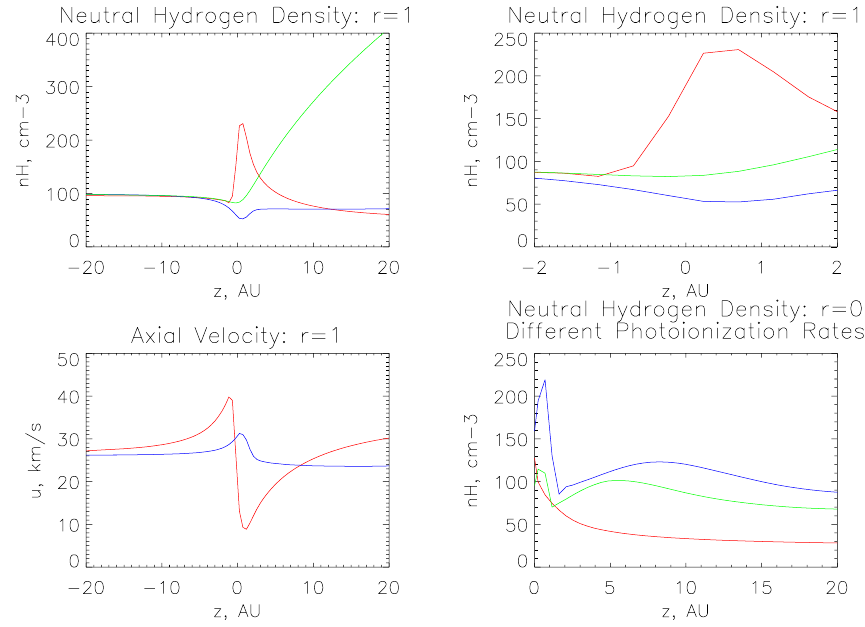
Fig. 2. Top: number density of the IC H-atom flow versus axial distanse z , at a radial coordinate r = 1AU. n i = 100cm − 3 , V i = 26km/s, T i = 100K. β 0 = β φ ,µ = 0 . 1, the spatial resolution along the z -axis is 0.5AU. The role of gravity is illustrated by the presence ( G 6= 0) and absence ( G = 0) of the gravitational field of the Sun, shown by red and blue curves, respectively. The density distribution in the cold kinetic model (see text) with the same input parameters is shown by the green curve. Bottom, left: axial component of velocity versus Z for the same parameters as in the top. Bottom, right: density distribution in downstream region, calculated for different photoionization rates is shown by red ( β φ = 8 · 10 − 8 s − 1 ), green (5 · 10 − 8 ) and blue (3 · 10 − 8 ) curves,